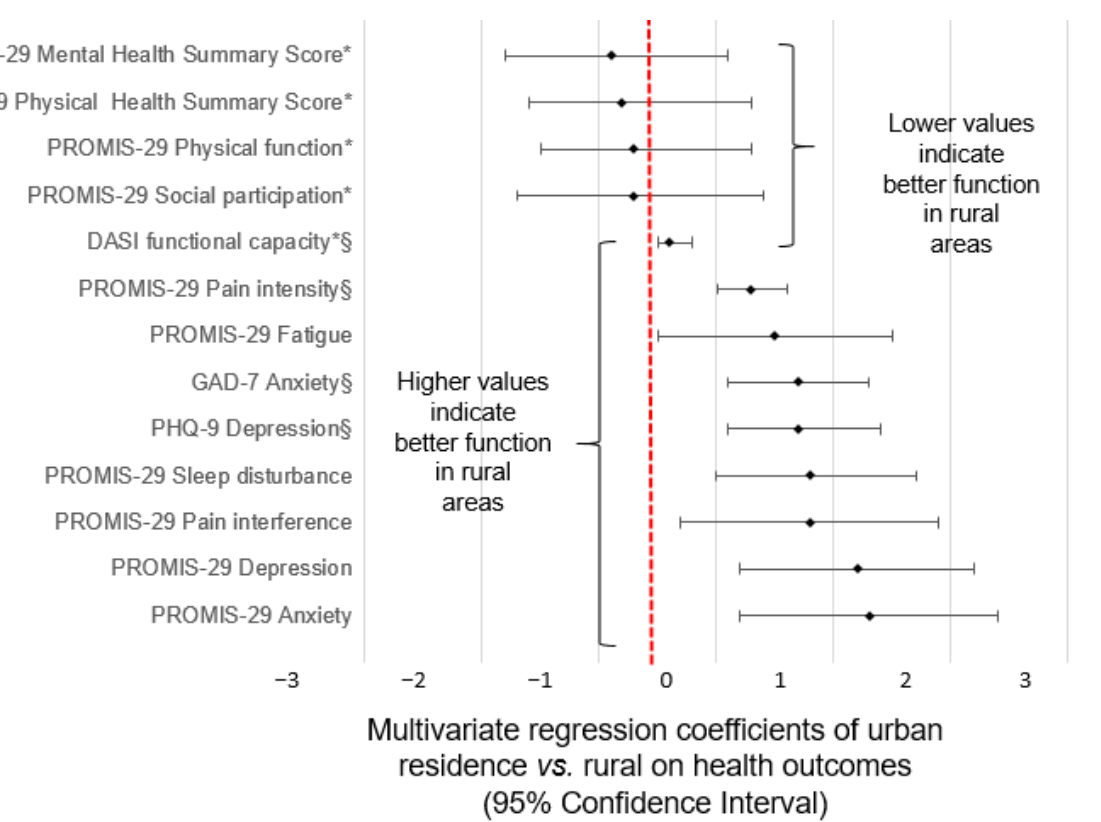
Figure 1. Urban vs. rural differences in mental, physical, and social health and well-being. Regression coefficient ( β ) and 95% Confidence Interval for the mixed linear regression with adjustment for all potential confounders. The vertical line at zero represents a null association. The regression coefficients indicate the scores of urban residents relative to rural residents. In each case, the effect suggests better outcomes among rural residents, although not all are statistically significant. * Reverse scale: lower scores are worse § Different scale.